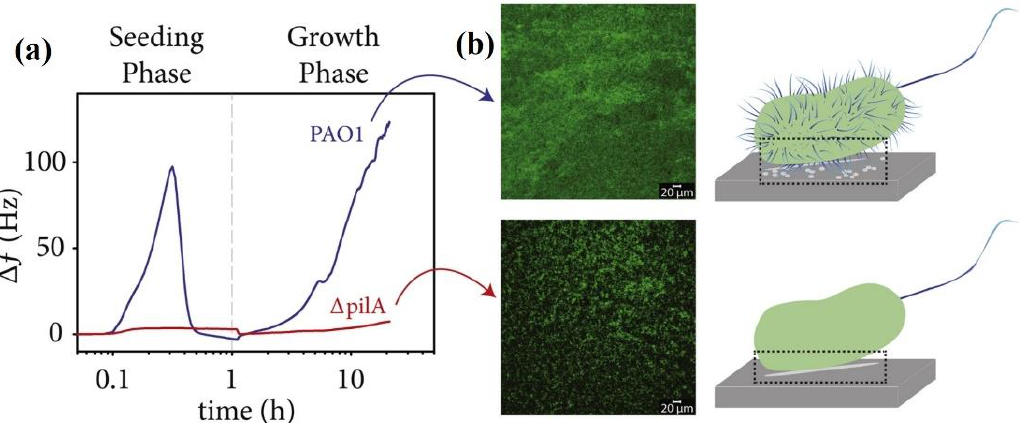
Figure 14. QCM-D for bacterial attachment and subsequent growth. ( a ) Representative requency shifts ( ∆ f ) of the 3rd overtone during an initial seeding period and the subsequent biofilm growth period for wild-type P. aeruginosa PAO1 and the ∆ pilA mutant. The arrows indicate the characteristic recurrent fluctuation in quartz crystal microbalance with dissipation (QCM-D) signal observed between 4 and 6 h P. aeruginosa PAO1 biofilm growth. ( b ) Representative maximum intensity projections of CLSM image stacks of P. aeruginosa PAO1 and ∆ pilA mutant biofilm development on QCM-D crystals. (Reproduced with permission from